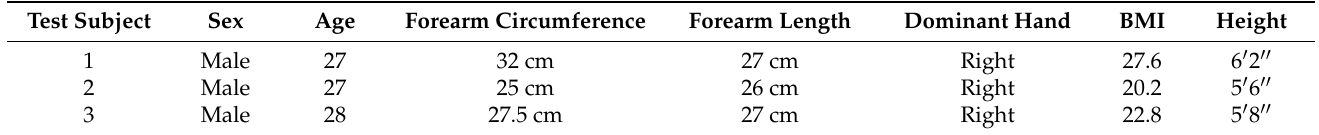
Table 2. Anthropometric